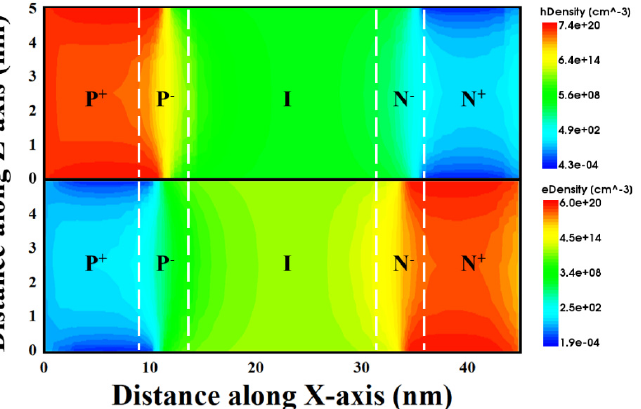
Figure 5. Contour plots of electron and hole carrier density for Fe-ED NSTFETs after pulse, at V PG = V GS = V DS = 0 V, showing nonvolatile and reconfigurable doping.